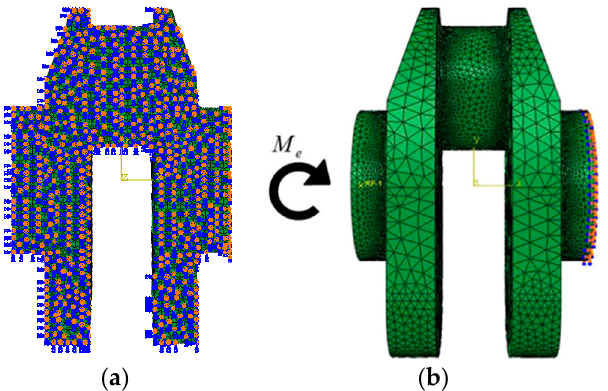
Figure 13. The finite element model of the crankpin. ( a ) The boundary condition on the symmetrical plane; ( b ) the load and boundary condition on the right face.